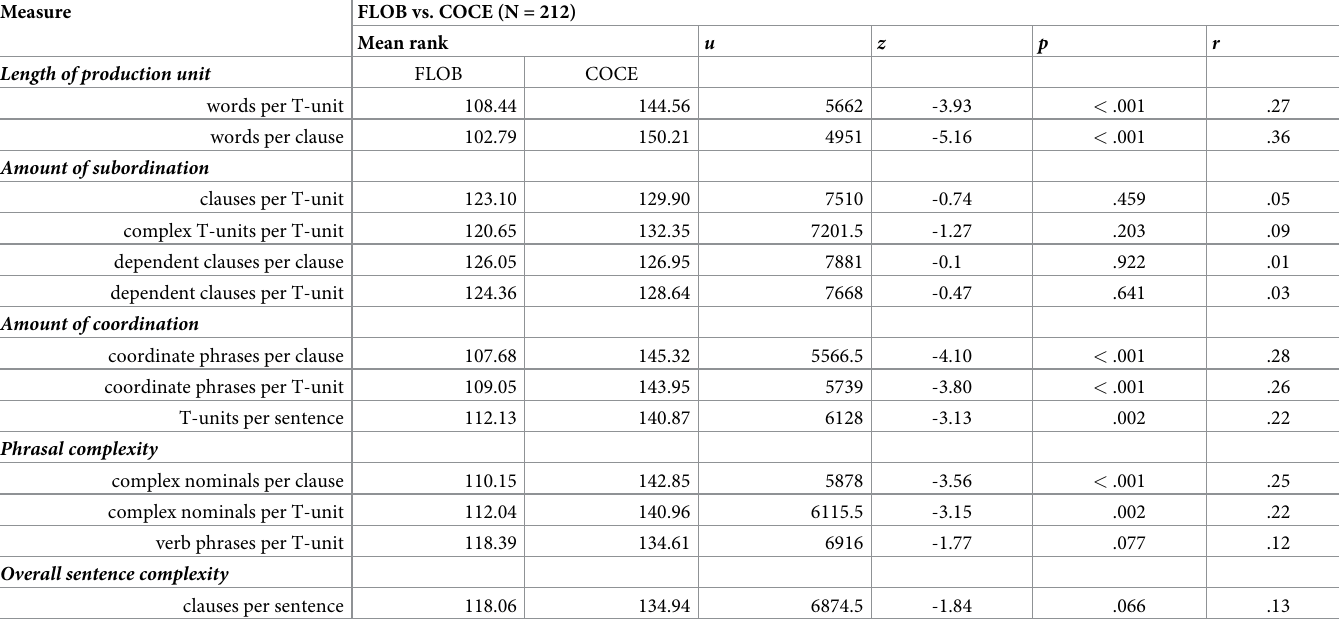
Table 9. Mann-Whitney tests on syntactic complexity between FLOB fiction and COCE